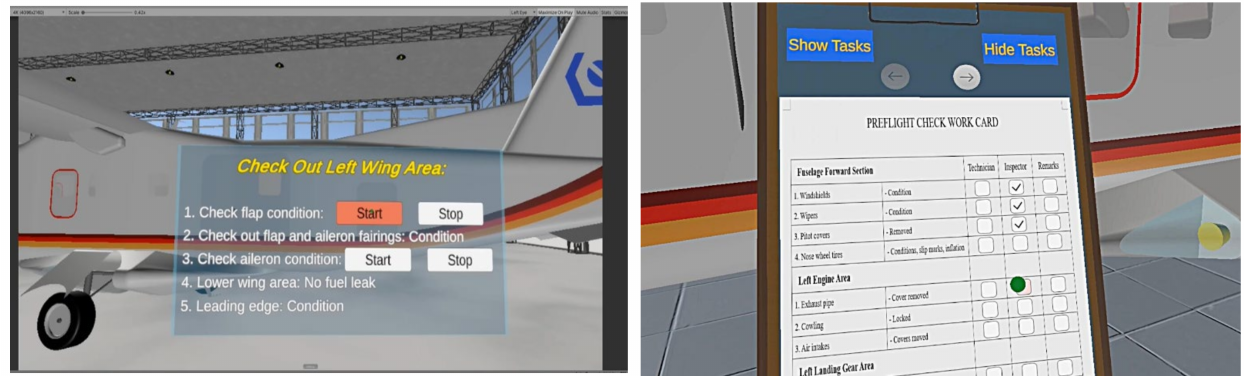
Figure 4. Walk-around inspection screen.